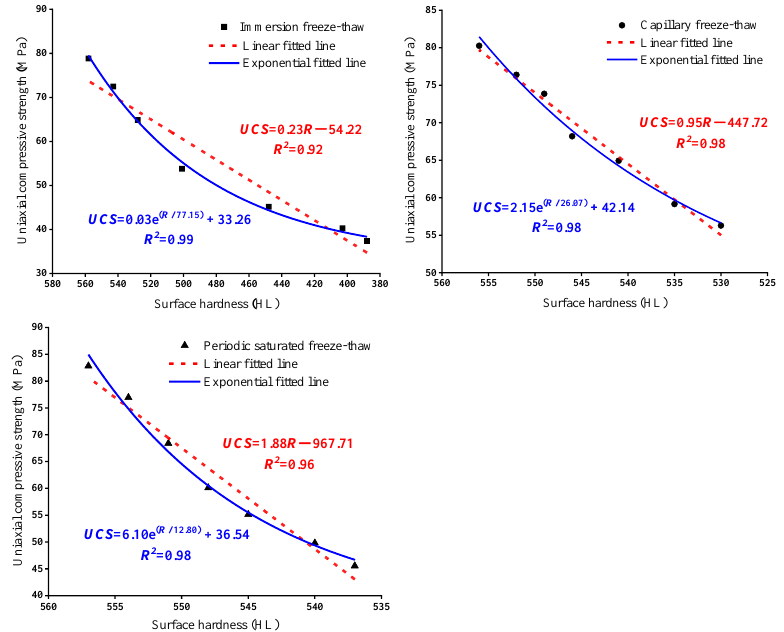
Figure 17. Correlation curve between surface hardness and UCS of rock sample.